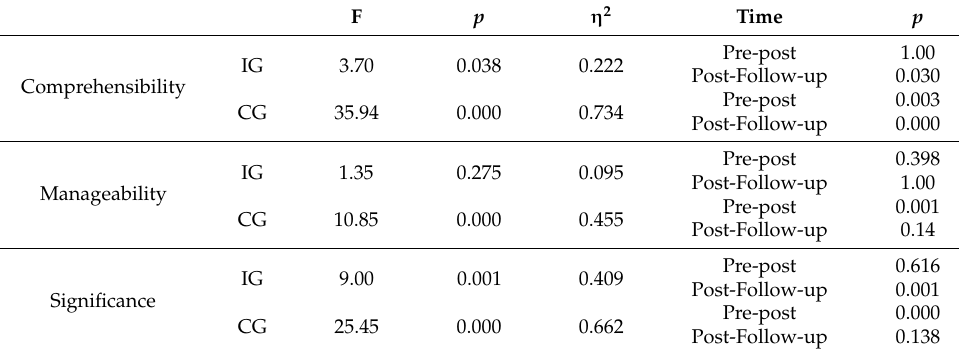
Table 6. Univariate analysis of the evolution of the groups independently over